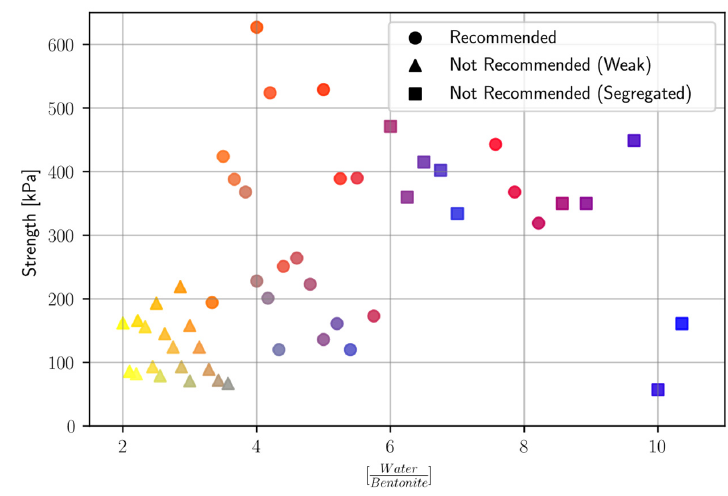
Figure 12. Strength vs. water/bentonite ratio.